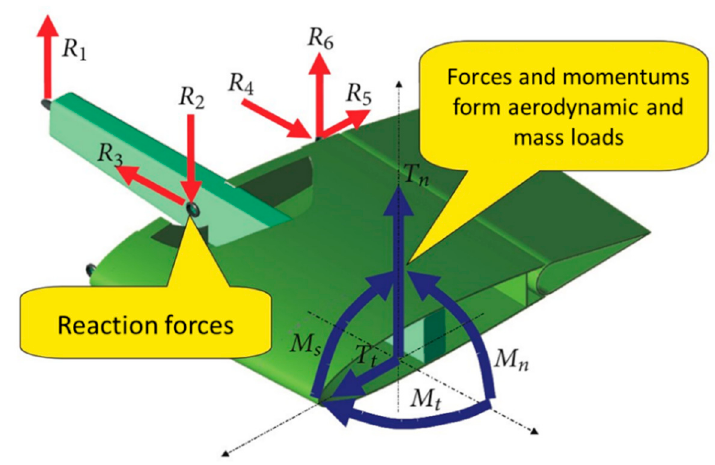
Figure 11. Loads and reactions in the wing